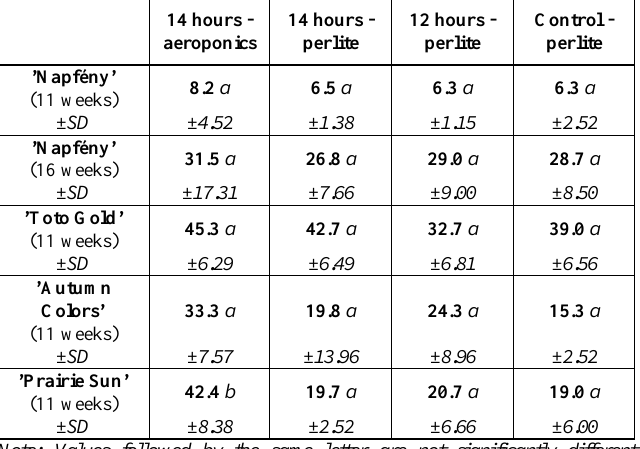
Figure 6. Number of leaves of 11 weeks-old Rudbeckia hirta L. varieties (’Napfény’, ’Autumn Colors’) depending on photoperiodic lighting treatments,